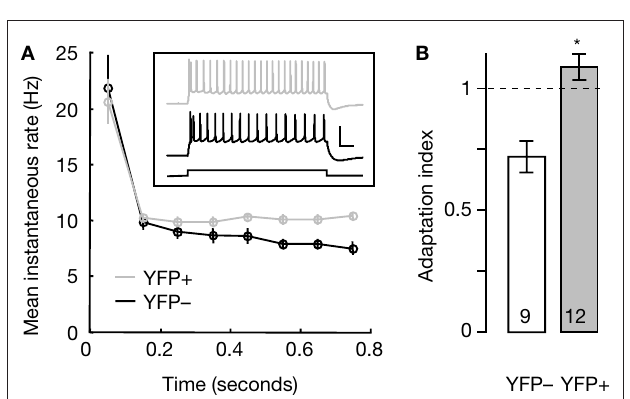
FIGURE 4 | Plots of average strength of inputs from different map rows, as a function of the normalized soma positions of the YFP-positive and YFP-negative neurons. Brackets indicate the upper and lower blades of YFP-positive neurons. (A) Average strength of